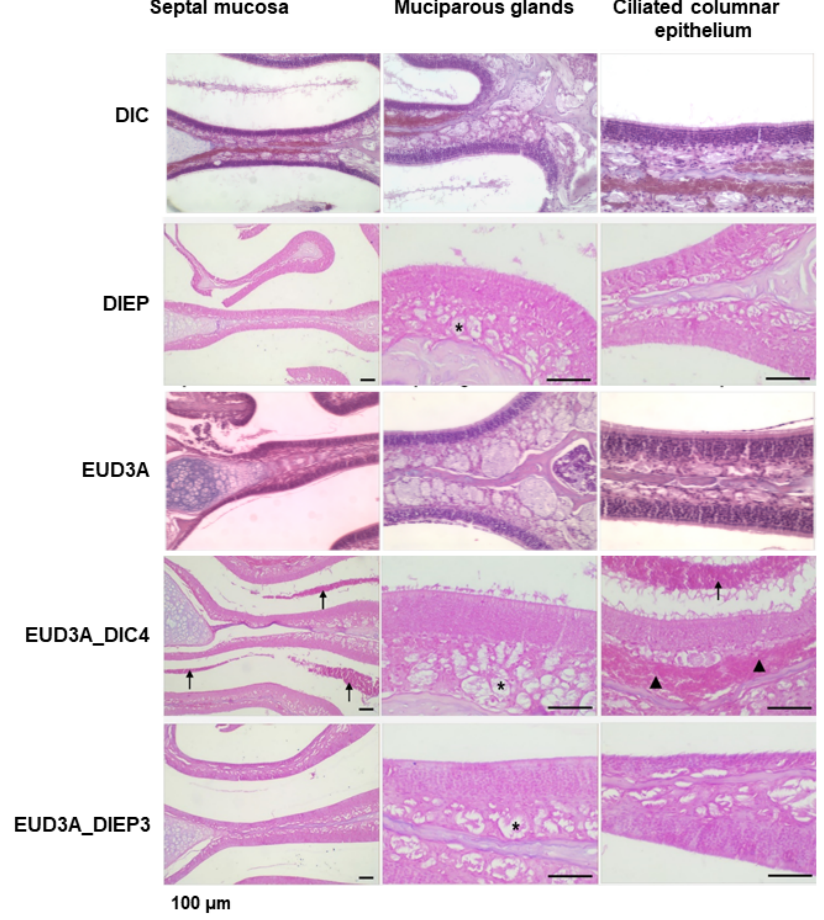
Figure 5. Histological features of the nasal mucosa of mice administered with the control formulation of unloaded EUD NPs (EUD3A); neat diclofenac (DIC) and diclofenac epolamine (DIEP); and EUD NPs with loaded with DIC or DIEP (EUD3A_DIC4 and EUD3A_DIEP4). Hematoxylin and eosin; bars = 100 μ m.